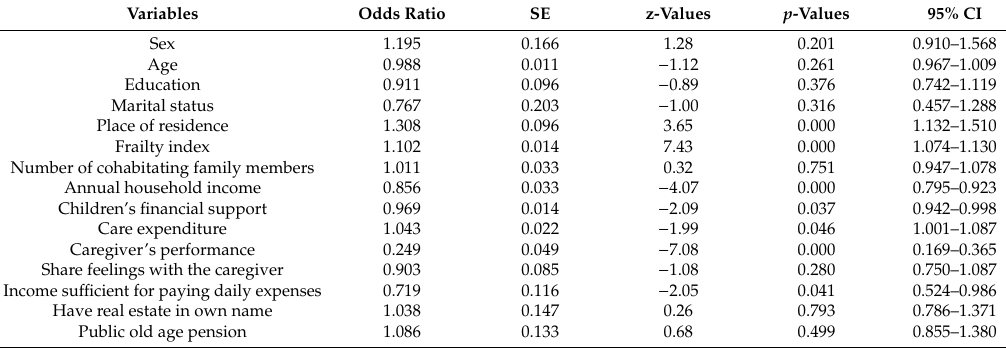
Table 3. Binary logistic regression analysis of the influencing factors for undermet care needs in the disabled oldest old